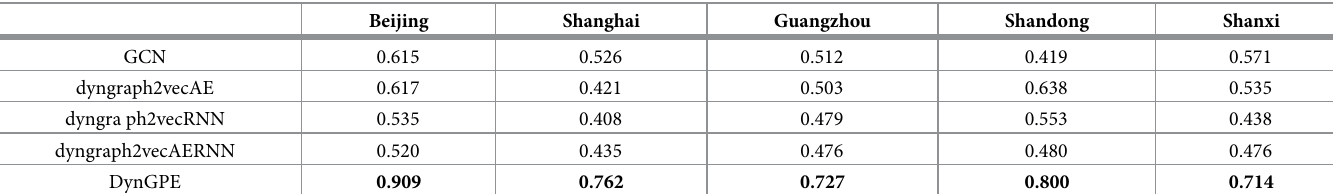
Table 1. Comparison experiments by using IF.